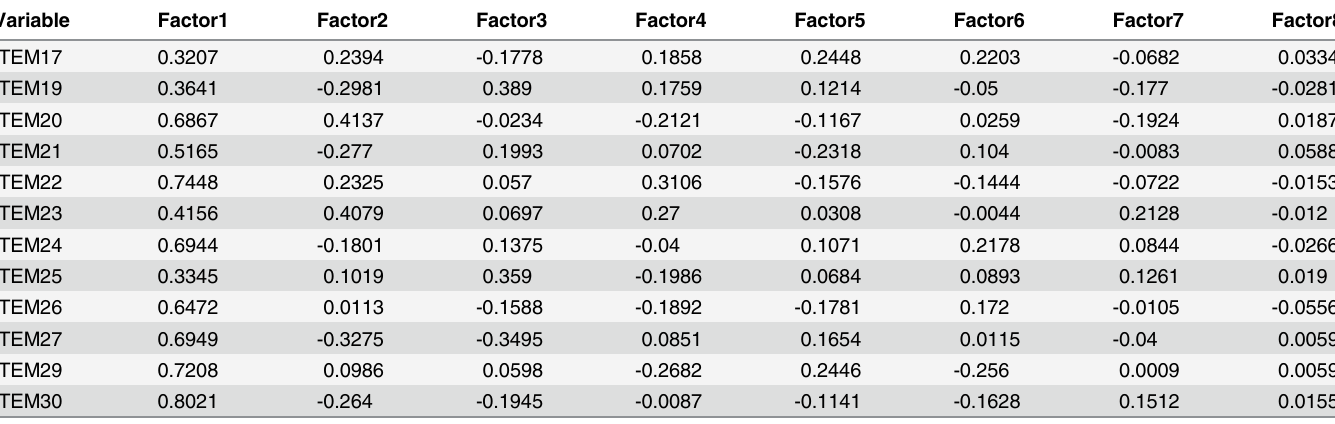
Table 7. Factor loadings of the domain C in the Osteoporosis Prevention and Awareness Tool (OPAAT) using exploratory factor analysis (EFA).